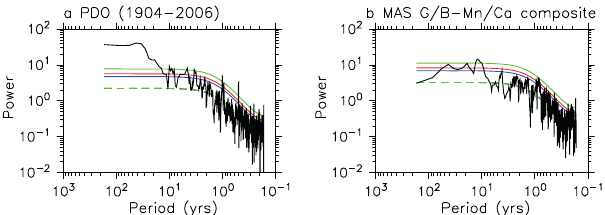
Fig. B2. Spectrum of (a) the PDO index (Mantua et al., 1997) and (b) the MAS1/3 G/B-Mn/Ca composite record. Monthly anomaly data from January 1904 to October 2006 are used, whereby the monthly climatology of 1904–2005 is removed. Confidence levels are indicated with green (99%), red (95%), blue (90%) and green dashed (median) lines, respectively.